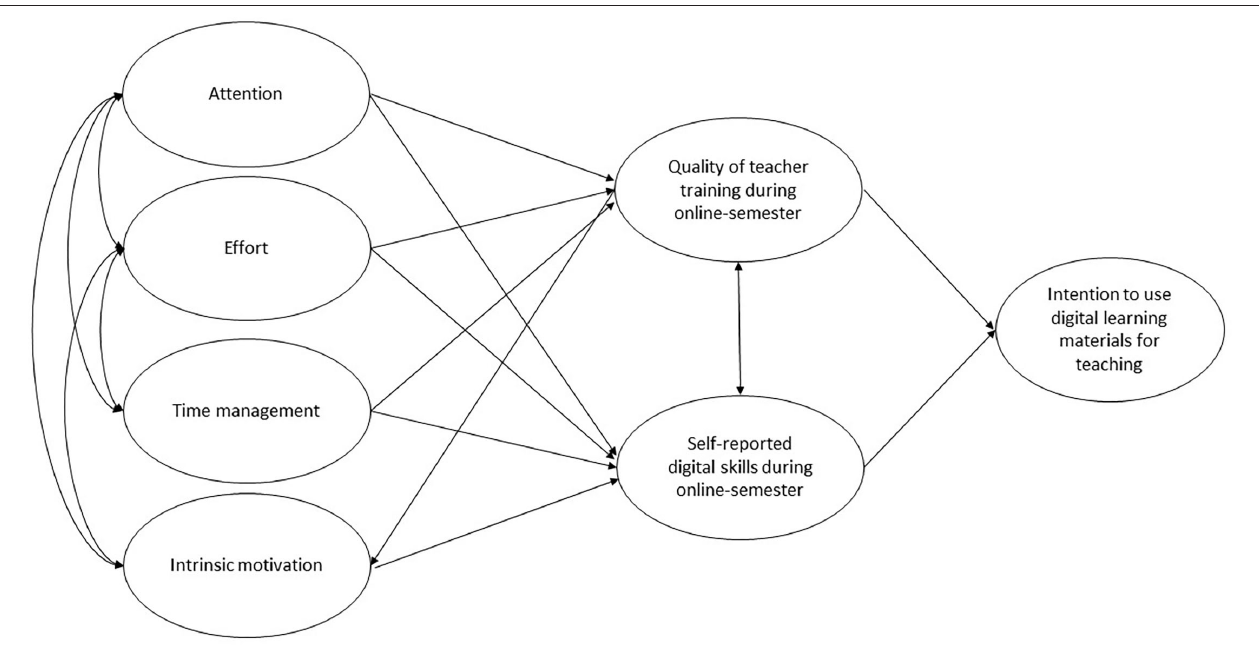
FIGURE 1 | Hypothetical